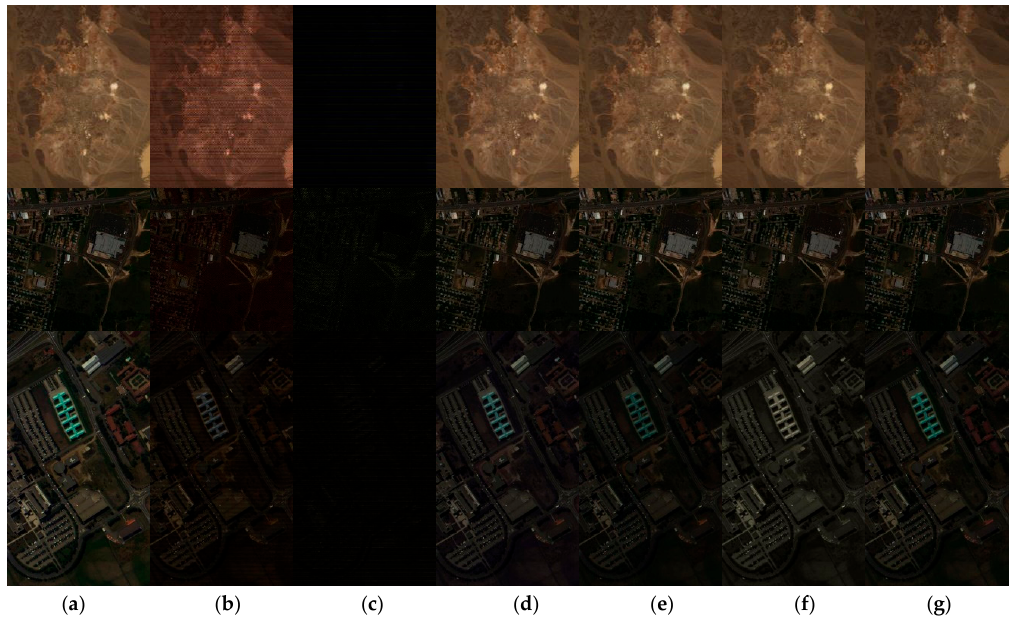
(c) Figure 5. Mean peak signal-to-noise ratio (MPSNR) curves of different algorithms for different datasets: ( a ) Cuprite dataset, ( b ) Urban dataset, and ( c ) PaviaU dataset. Figure 6 shows the visual qualities of the original and reconstructed pseudocolor images for the different datasets. The sampling rate is set to 0.0564, 0.0589, and 0.0581 for Cuprite, Urban, and PaviaU dataset, respectively. It can be seen from the figure that the CPPCA algorithm can hardly recover the original image near the 0.05 sampling rate. The reconstruction quality of MT-BCS is also very poor. The compressed sensing reconstruction algorithms based on LMM can recover the original image better, and the spatial details are well preserved. However, slight color distortion can still be observed on the PaviaU dataset. This color distortion phenomenon indicates that the LMM-based reconstruction algorithm has excellent performance in preserving spatial information,